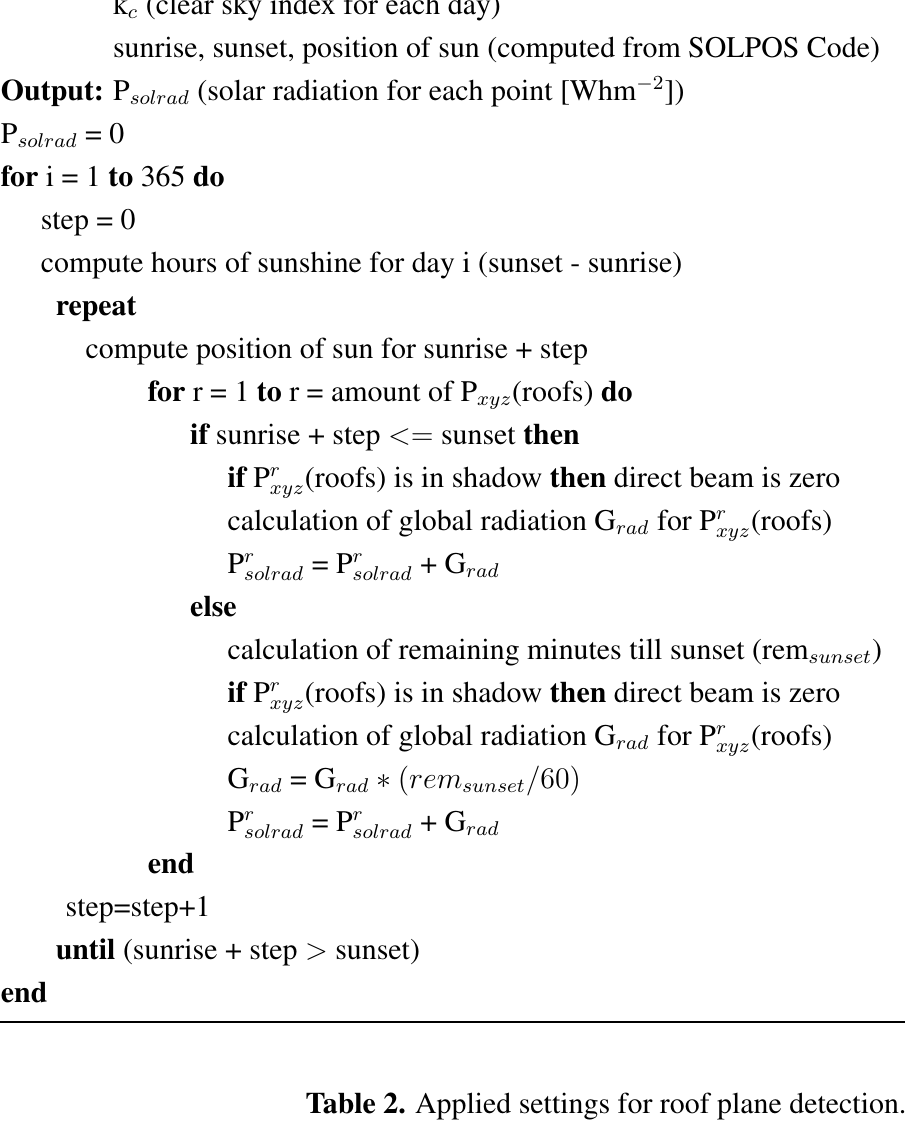
Table 1. Pseudo Code for solar potential analysis.